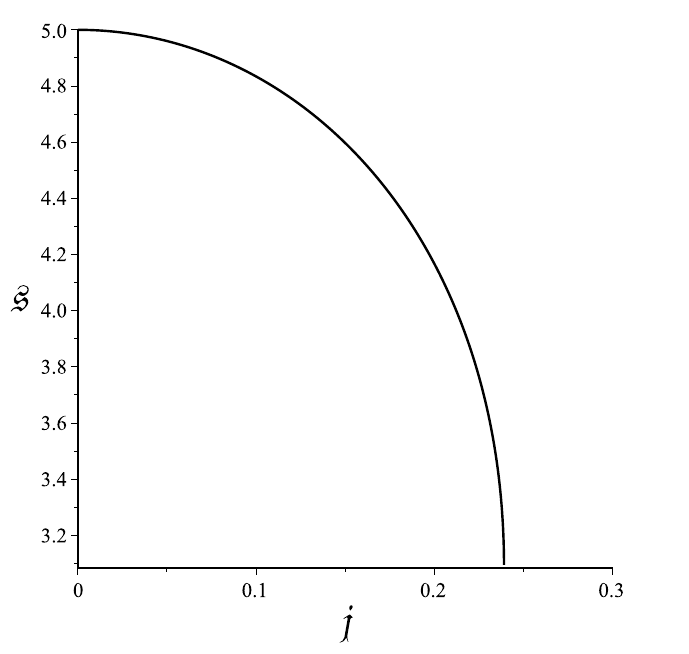
Figure 2 . Specific entropy of a four-dimensional asymptotically flat Kerr black hole with fixed temperature 0.1 in Planck units, as a function of the specific angular